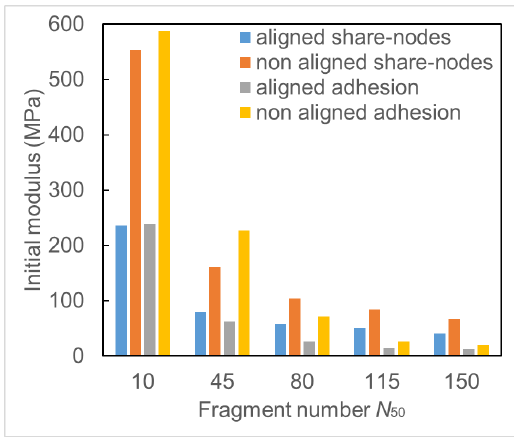
Fig. 7 Relationships of fragment number and initial modulus from MTCT